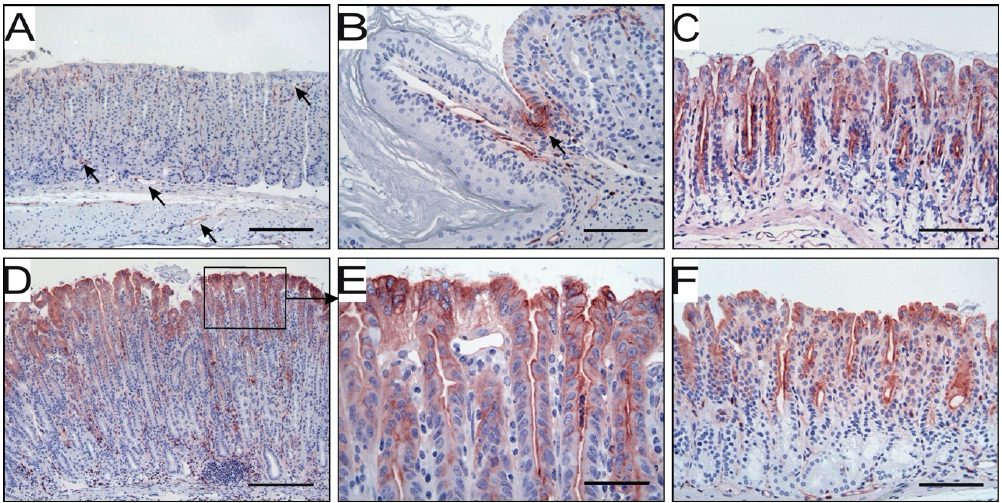
Figure 3. uPAR expression at different anatomical locations in non-infected and H. pylori-challenged mice . In the corpus of unchallenged mice, uPAR is detected by immunohistochemistry in endothelial cells (arrows) and a few scattered neutrophils ( A ), as well as in some transitional cells of the squamo-columnar junction ( B ). Epithelial cells in the corpus are negative for uPAR ( A ), while some expression is found in antral epithelium ( C ). Thirty weeks after H. pylori inoculation, intense uPAR expression appears in the corpus epithelium ( D ) at the apical membrane of foveolar epithelial cells ( E ). Epithelial cells of the antrum remain uPAR positive in H. pylori -infected mice ( F ). Scale bars: A and D ≈ 200 µm; B, C and f ≈ 100 µm; E ≈ 50 µm.